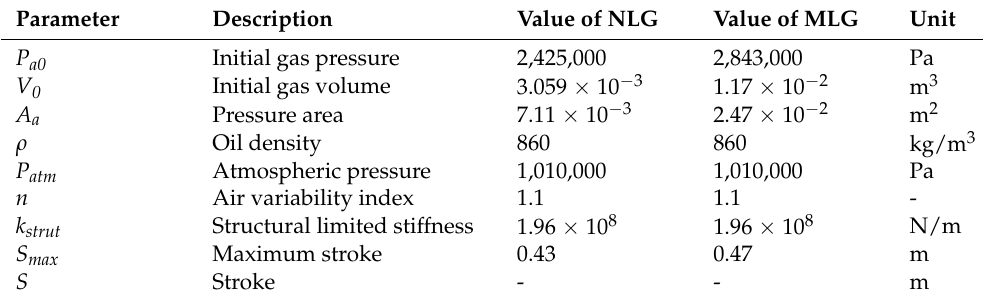
Table 2. Landing gear shock absorber